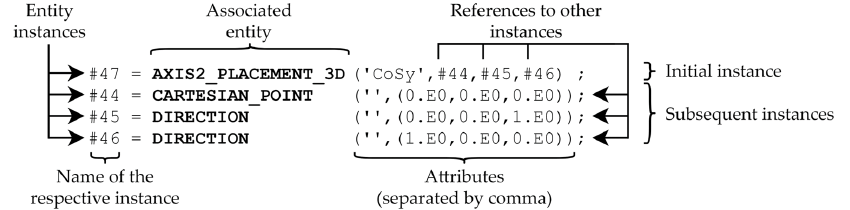
Figure 2. Required instances in a STEP-AP214-exchange file to represent the item coordinate system in the CAD system Creo Parametric 6.0.5.0.